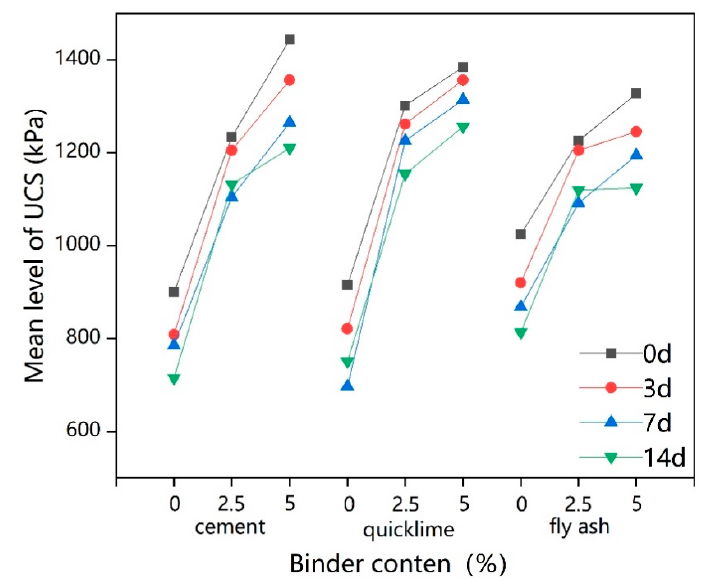
Figure 5. Intuitive trend chart of influencing factors for UCS.